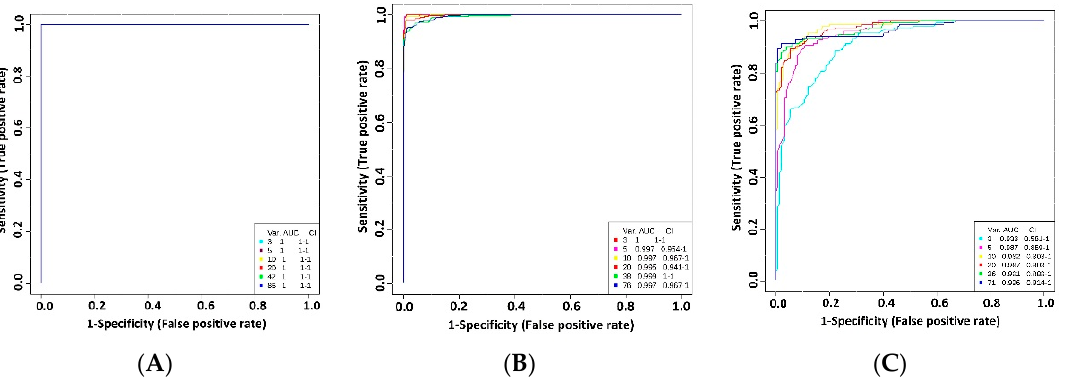
Figure 4. Performance of biomarkers in biological samples. Urine ( A ), faecal ( B ) and plasma ( C ) samples were taken from SLC6A19ko and SLC6A19wt mice. Univariate AUROC was used as classification and feature ranking method. In each Monte-Carlo Cross Validation, two-thirds of the samples were used to evaluate the importance of the metabolite. Different panels of important features were then used to build classification models, which were validated on the remaining samples. The different models with specific feature numbers written on the bottom right of the figure and their corresponding AUCs are shown on the figure. Var. (variables) indicates the number of selected metabolites.